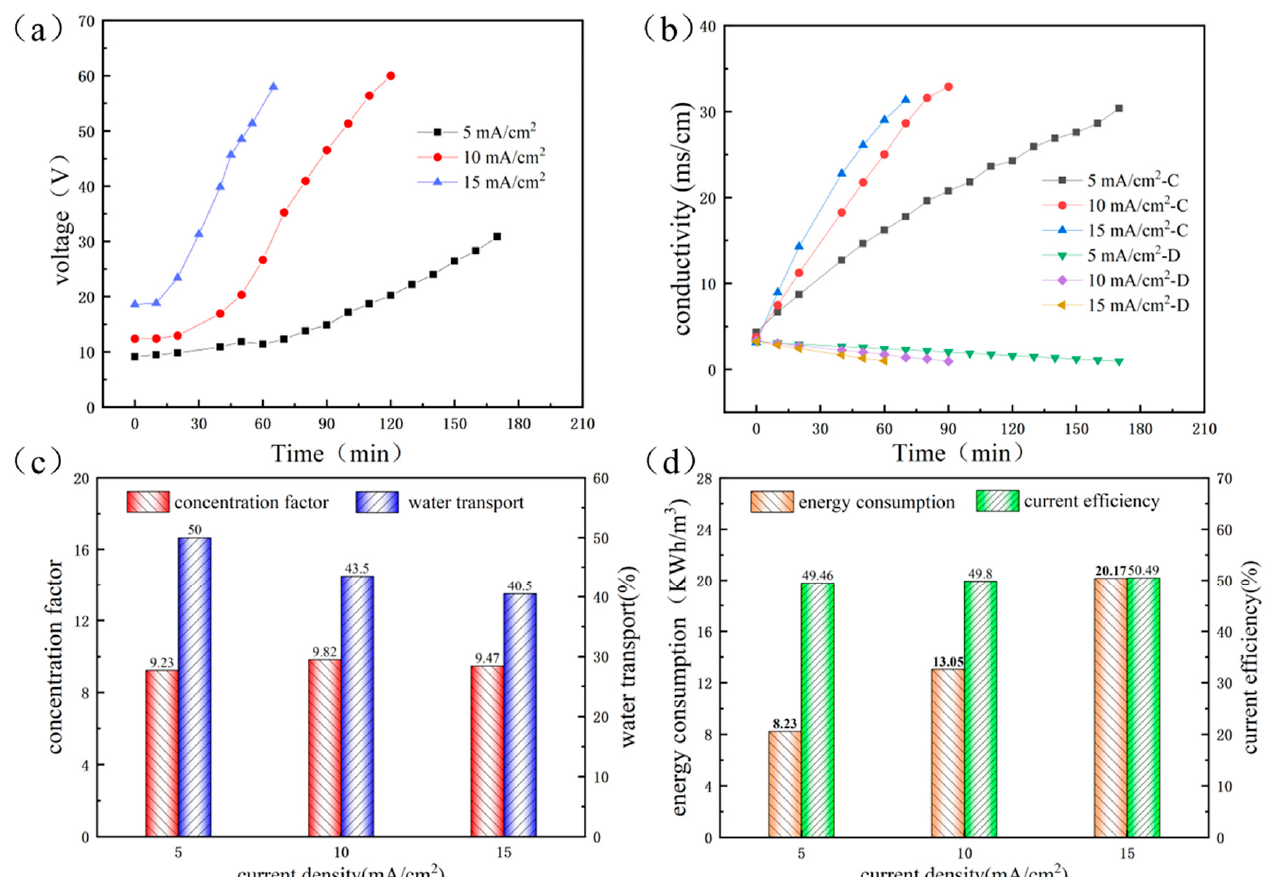
Figure 3. Effect of current density in first-stage ED process: ( a ) voltage drop, ( b ) desalination rate in the dilute and concentrate compartment, ( c ) concentration factor and water transport, and ( d ) energy consumption and current e ffi ciency.